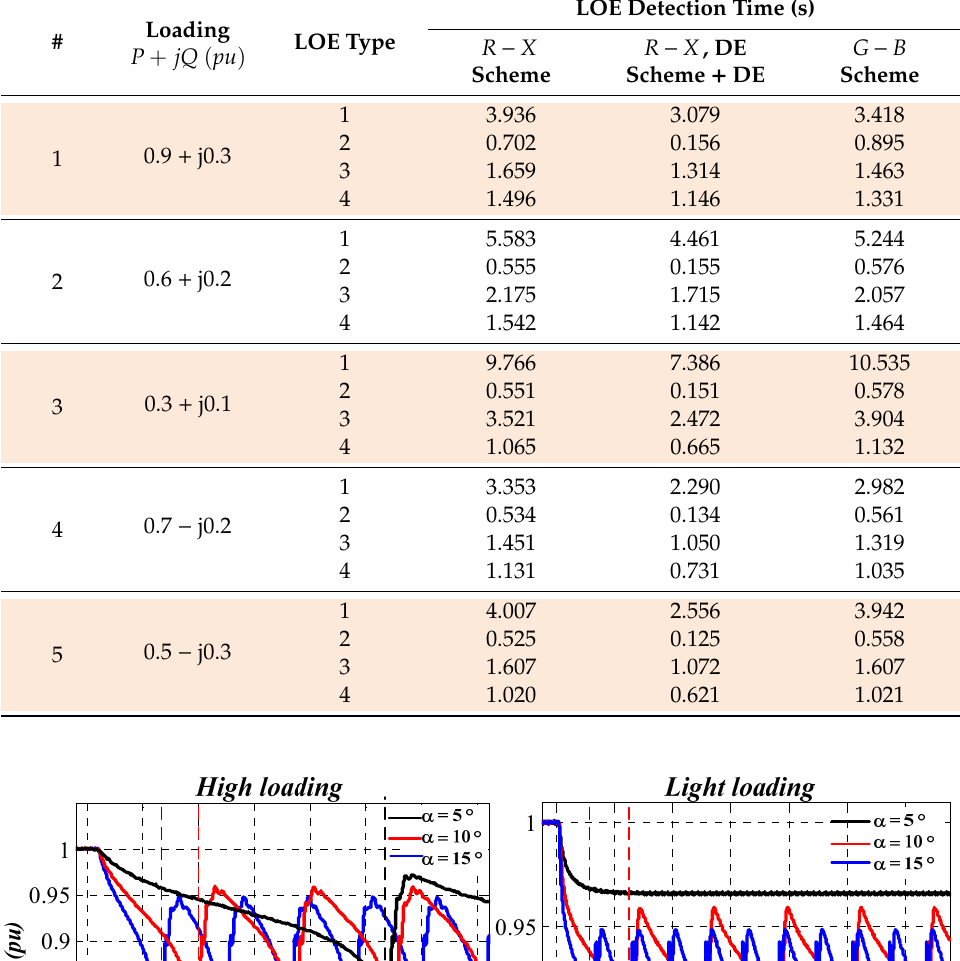
Table 2. The traditional relays performances during CLOE events in di ff erent loading operations.